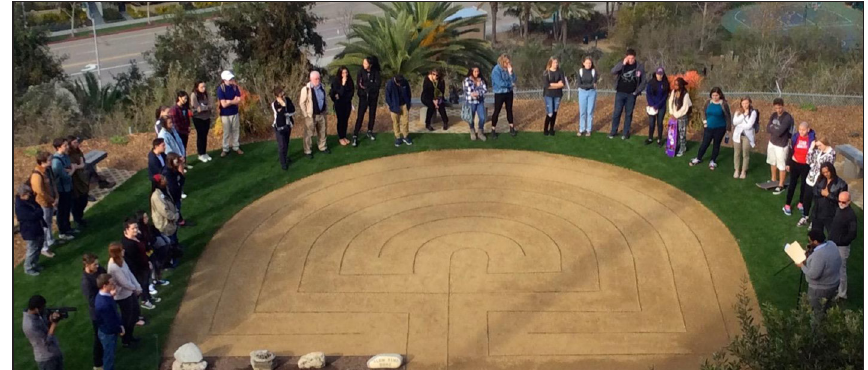
Figure 8: Consecration of labyrinth garden, Loyola Marymount University. Photo: Paul